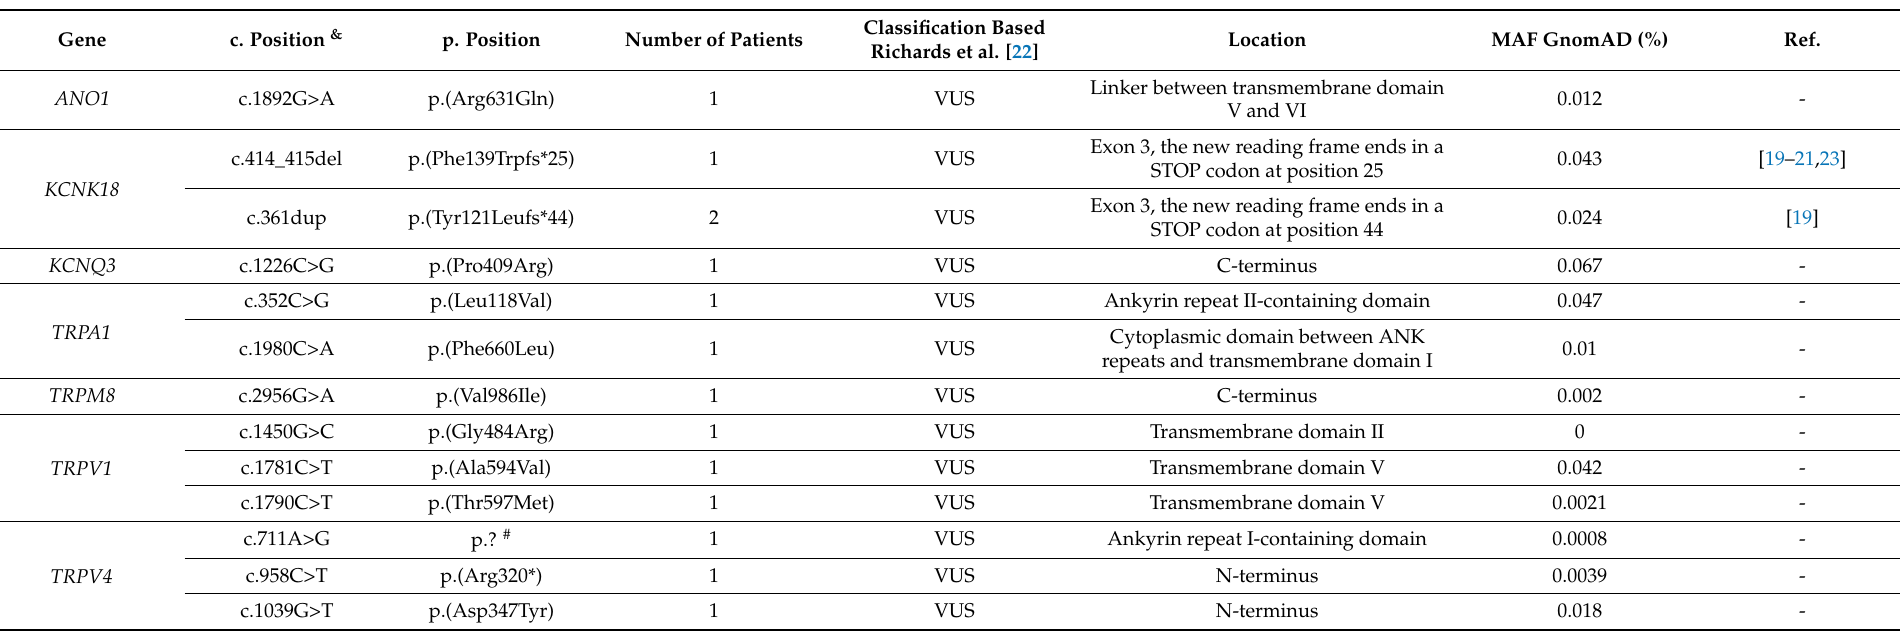
Table 3. Potentially pathogenic variants of ion channel genes identified in patients with painless-diabetic neuropathy ( n = 304). Gene c. Position & p. Position Number of